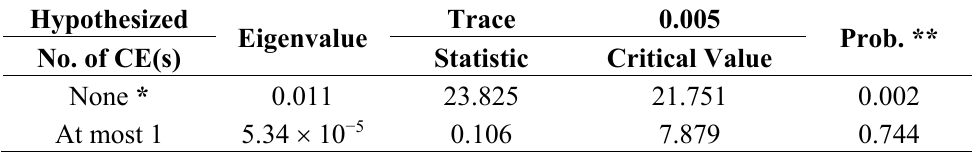
Table 1. Unrestricted Cointegration Rank Test.